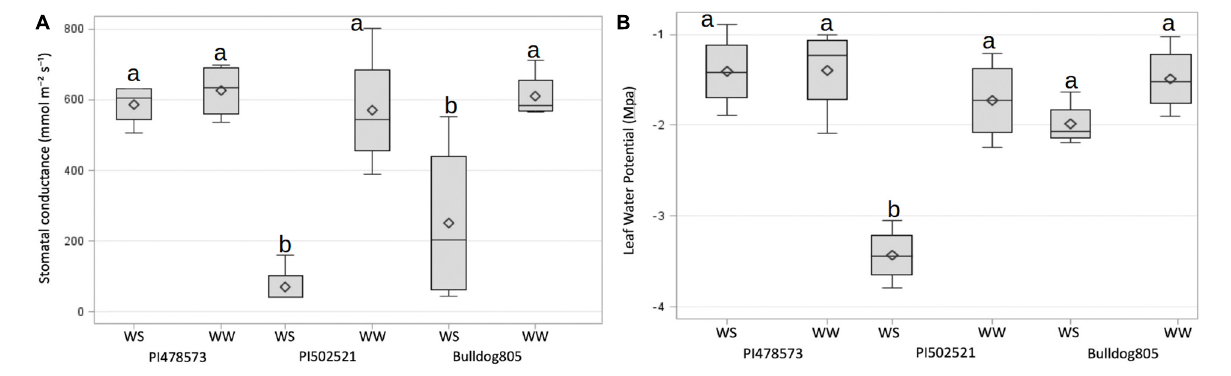
PVC and duration of drought stress imposed, PI502521 had a higher biomass yield under WS treatments in Exp. 1 and Exp.